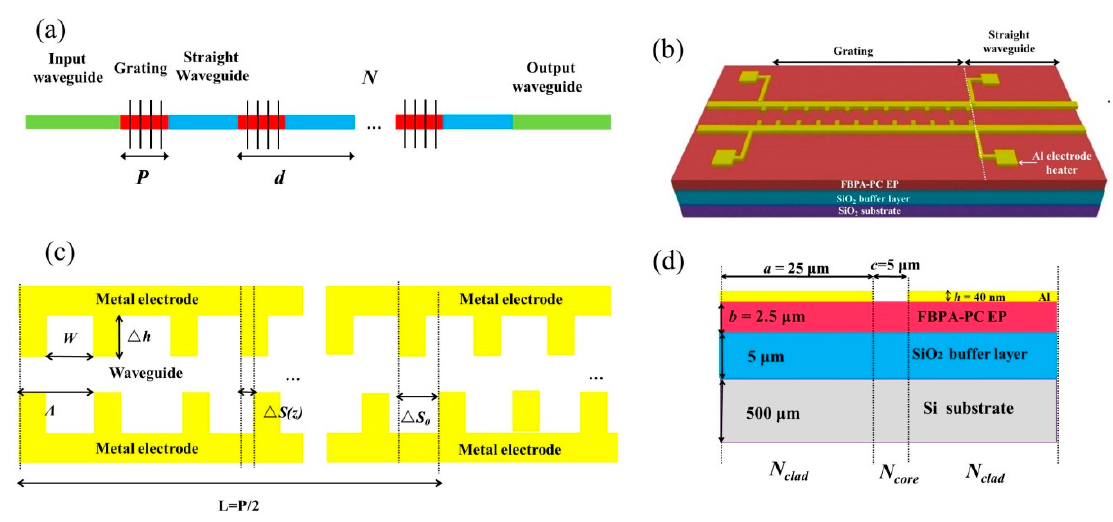
Figure 2. ( a ) Overall diagrammatic sketch of the sampled apodized waveguide grating; ( b ) Sketch of metal-printing sampled apodized waveguide grating in one sampling period; ( c ) Diagrammatic sketch view of the grating section with some important parameters; ( d ) Cross-section profile of this grating.